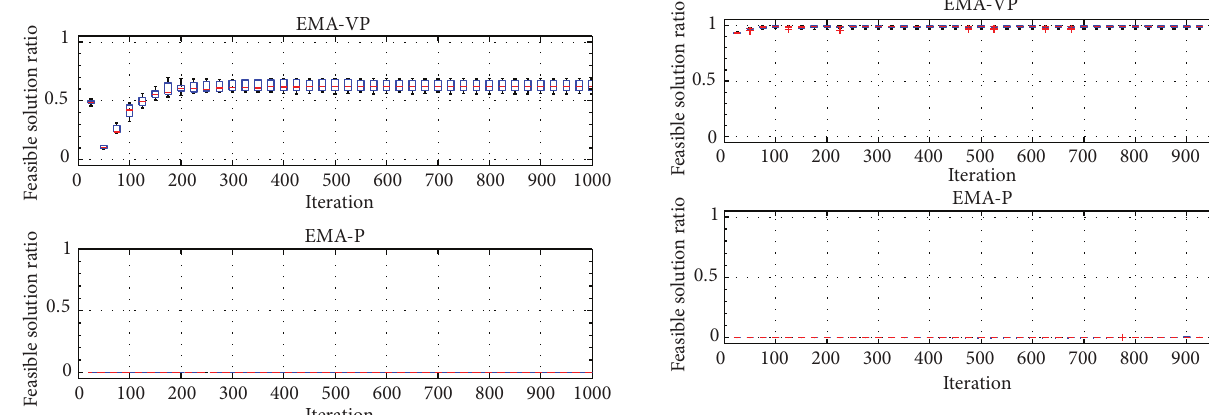
Figure 7: Ratio of feasible solutions for EMA-VP and EMA-P for RC 203.2.